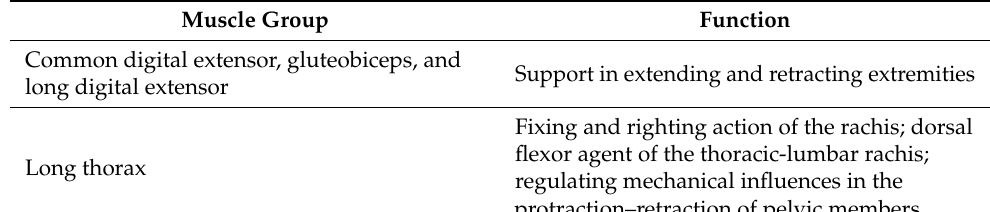
Table 1. Contribution of muscles to movement in fighting bulls. Muscle